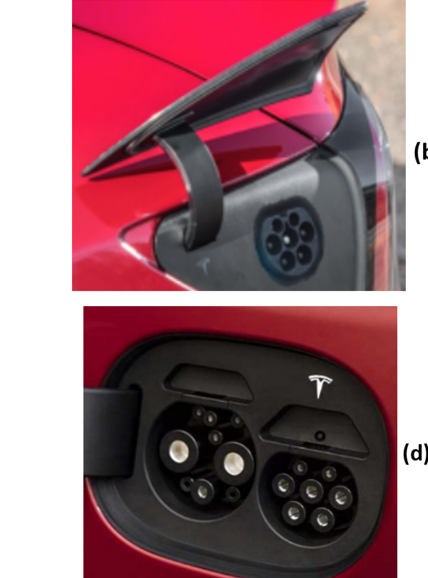
Figure 28. Tesla EV plug.